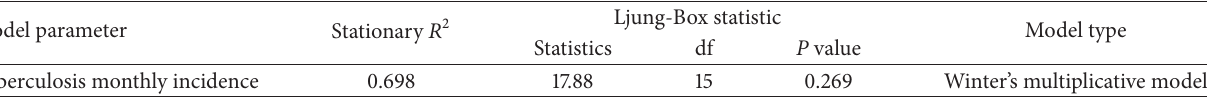
Table 3: Model statistics for tuberculosis data.